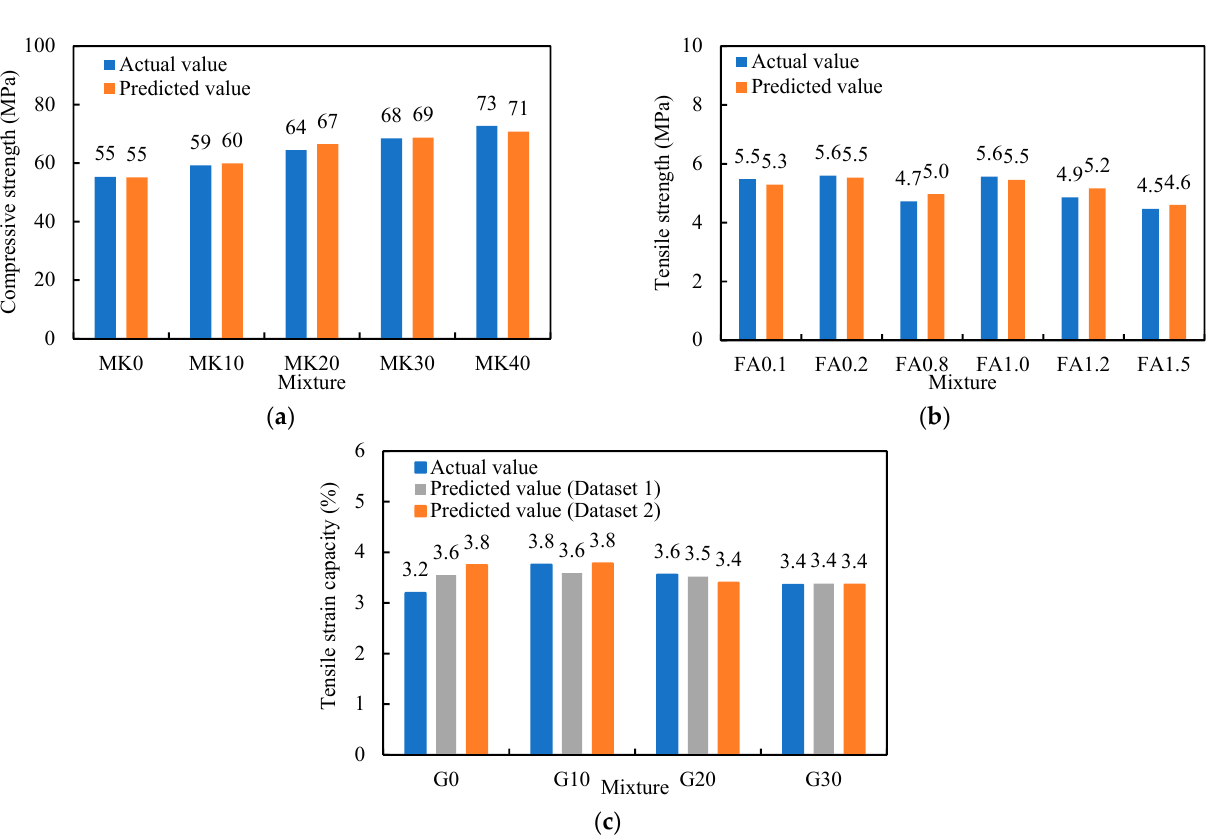
Figure 9. Comparison of the prediction against the test results: ( a ) compressive strength [77]; ( b ) tensile strength [22]; and ( c ) tensile strain capacity [63].